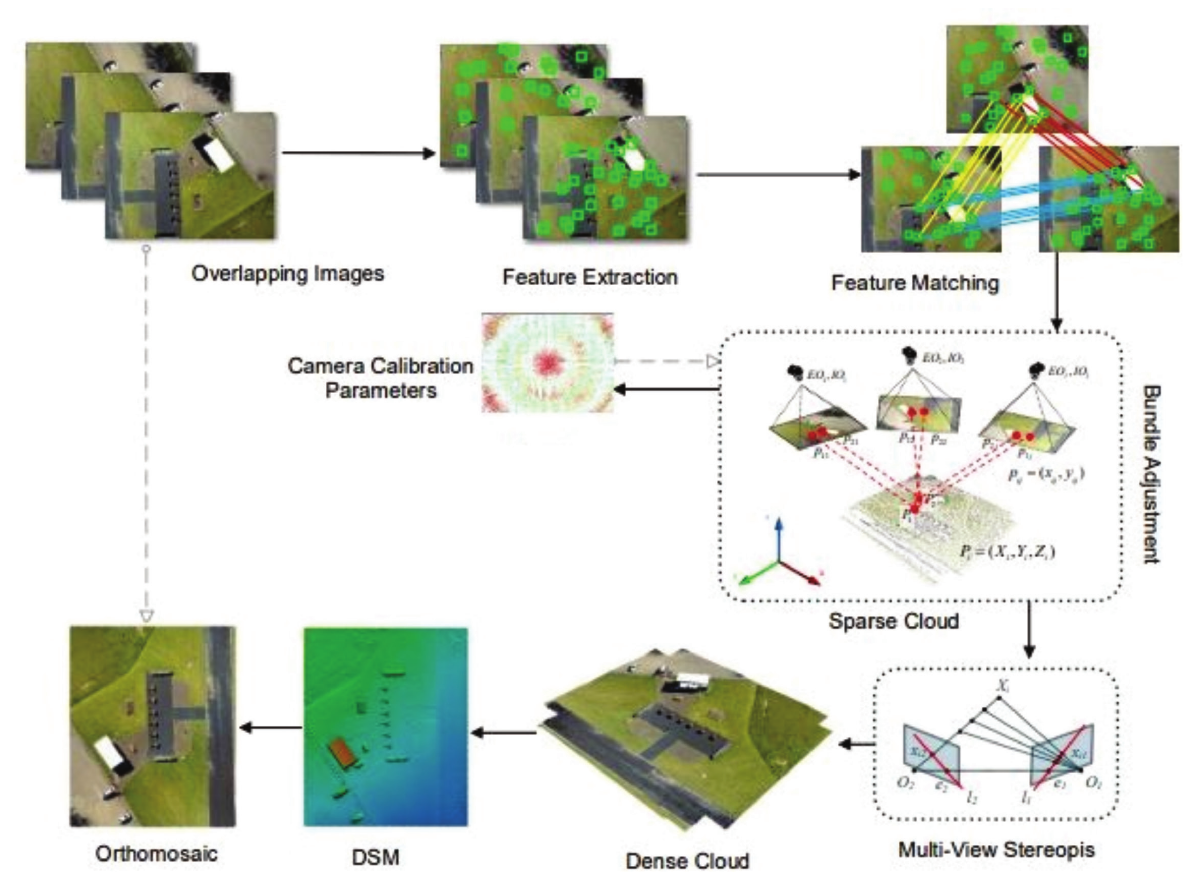
Figure 2. Flowchart of the photogrametry processing steps. Adapted from Javadnejad et al.